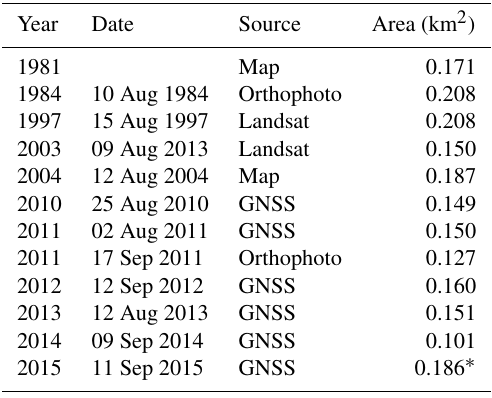
Table 1. Areal extents of Juvfonne derived from topographic maps, Landsat imagery, GNSS measurements by foot and digitizing from